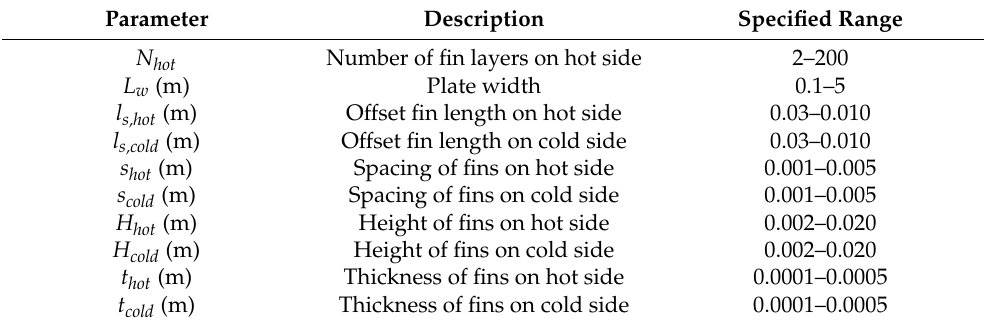
Table 2. Decision variables and corresponding specified ranges for multi-objective optimization of plate-fin heat